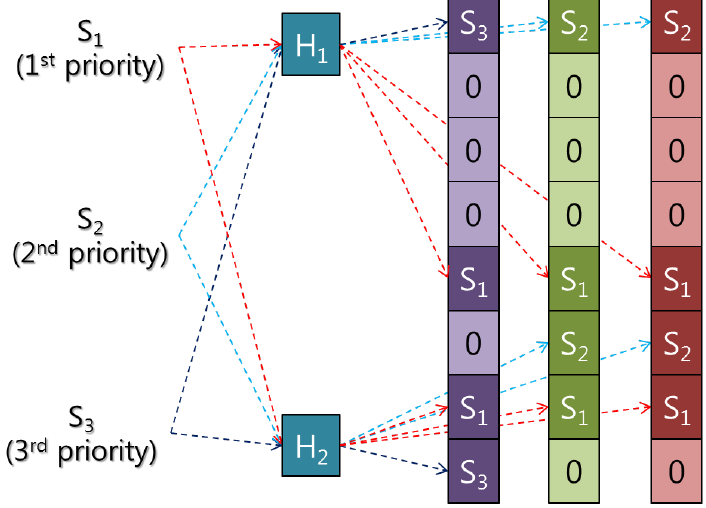
Figure 3. Simple example of the Insert phase of an IDS in the network